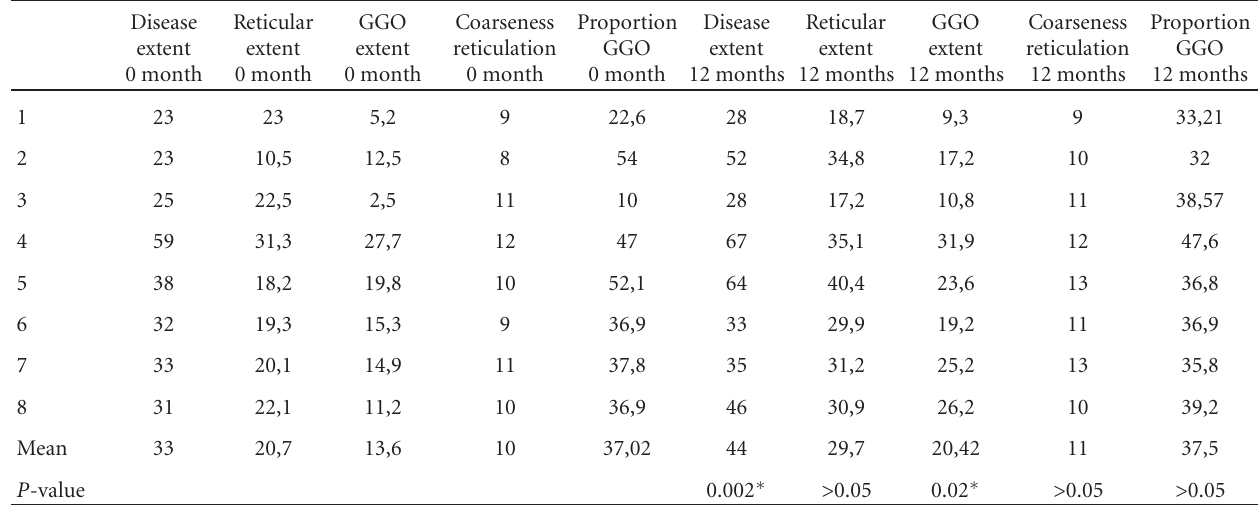
Table 3: HRCT scores before and after MMF treatment.